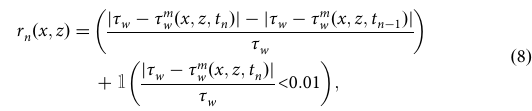
Table 1 List of channel fl ow test cases and corresponding Reynolds number, wall-normal grid resolution, and matching location h m . Re τ